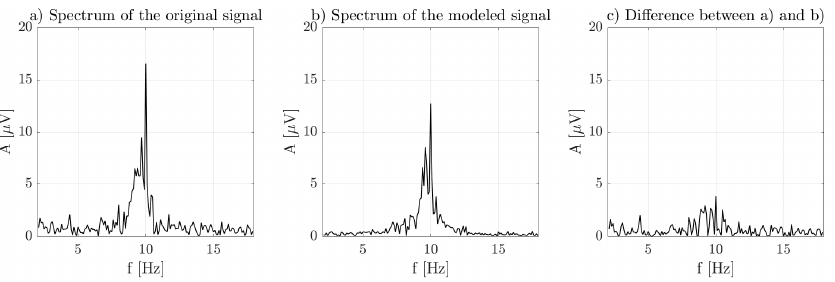
Figure 3. Visualization of the function minimized in this study. Plots ( a – c ) show spectra of the signals: original, modeled, and their difference, respectively. Note, that plot ( c ) is an absolute value of the difference.